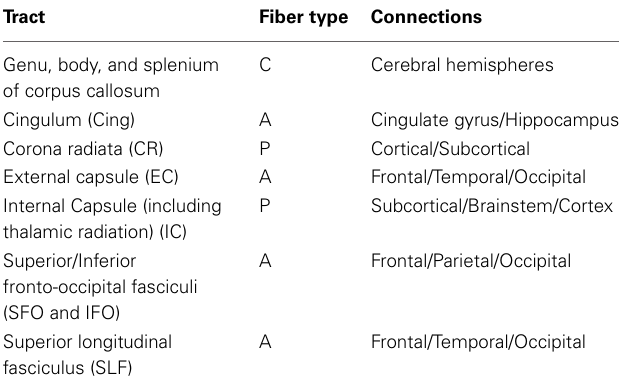
Table 2 | White matter tracts used in the analysis.